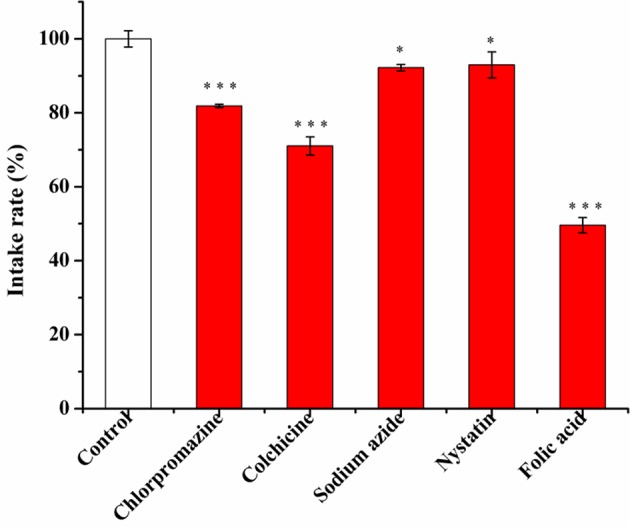
The effect of different inhibitors (chlorpromazine 10 μg/mL, colchicine 50 μg/mL, sodium azide 1 mg/mL, nystatin 6 μg/mL, folic acid 10 μg/mL) on the uptake of FA-CA-DOX micelles in cells within 4 h after incubation with cells for 2 h. Data presented as mean ± SD, n = 3, *P < 0.05 vs. control group, ***P < 0.001 vs. control group.